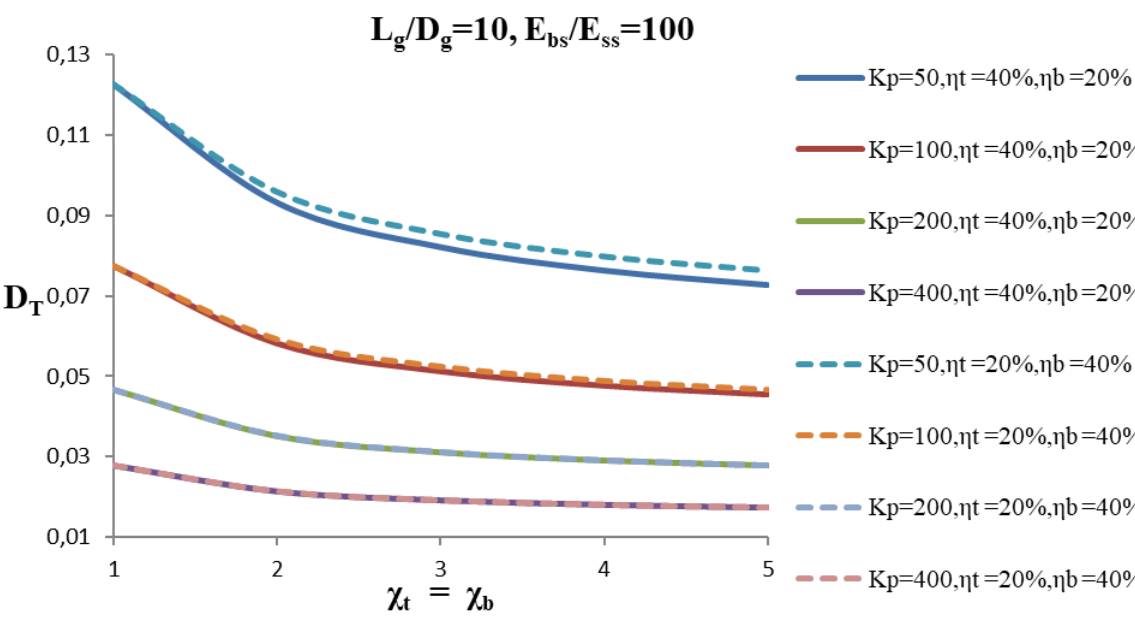
, with strengthening factor for the top, χ T ; PLST of GP, η p